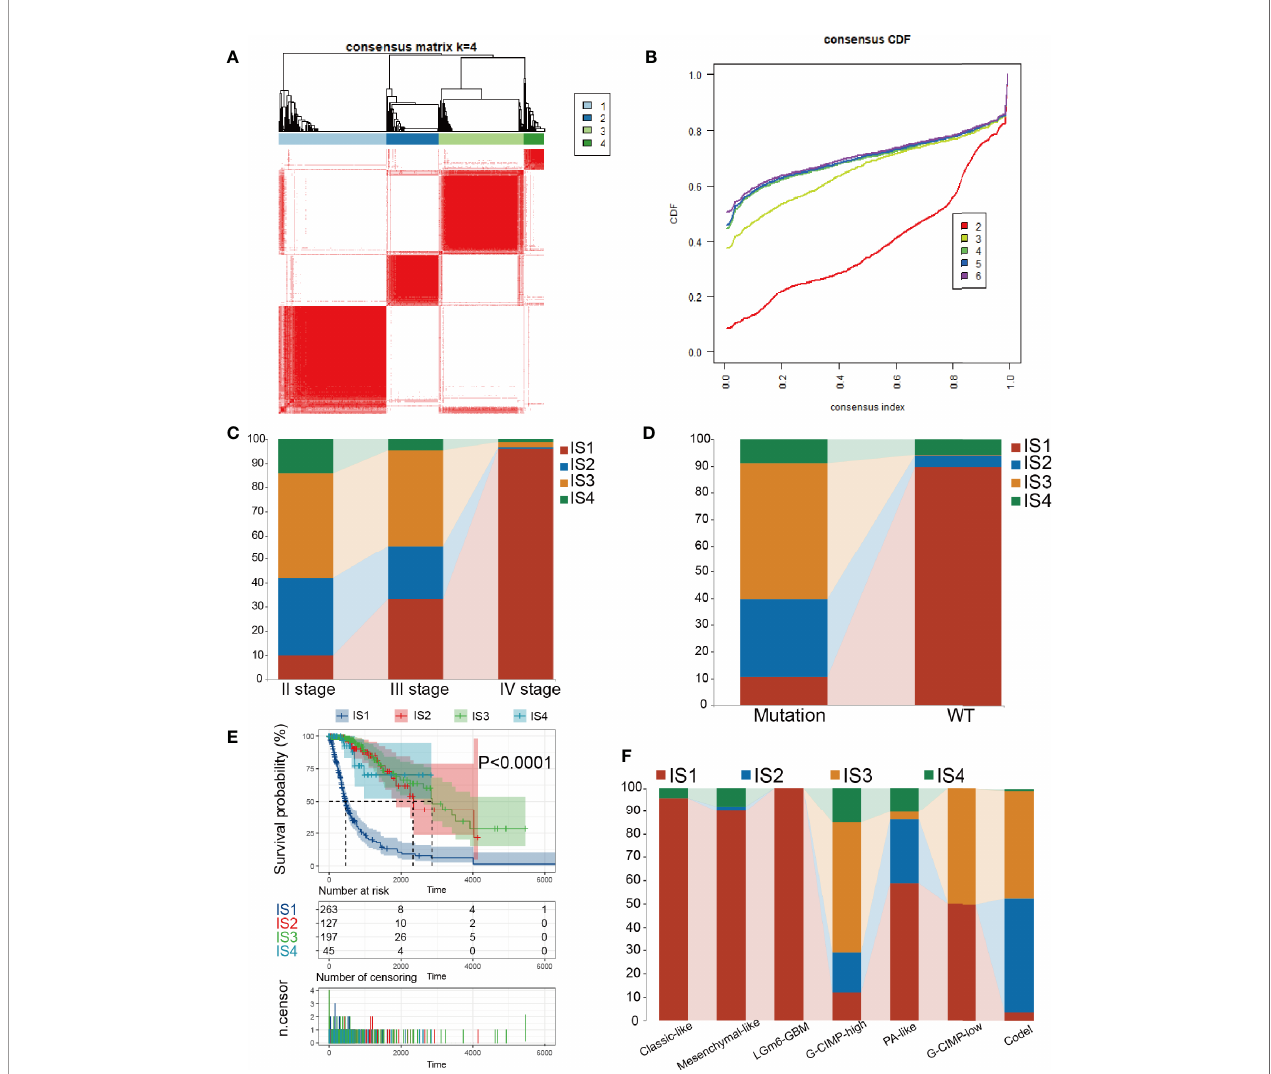
FIGURE 4 | Consensus clustering in TCGA. (A) Color-coded heatmaps corresponding to the consensus matrices. (B) Consensus Cumulative Distribution Function (CDF) Plot for immune-related genes in glioma. (C, D) Distribution of IS1-IS4 between WHO stages and IDH1 types in the TCGA cohort. (E) Kaplan-Meier curves survival based on the 4 glioma immune subtypes in the TCGA cohort. (F) Distribution of IS1-IS4 between methylation types in the TCGA